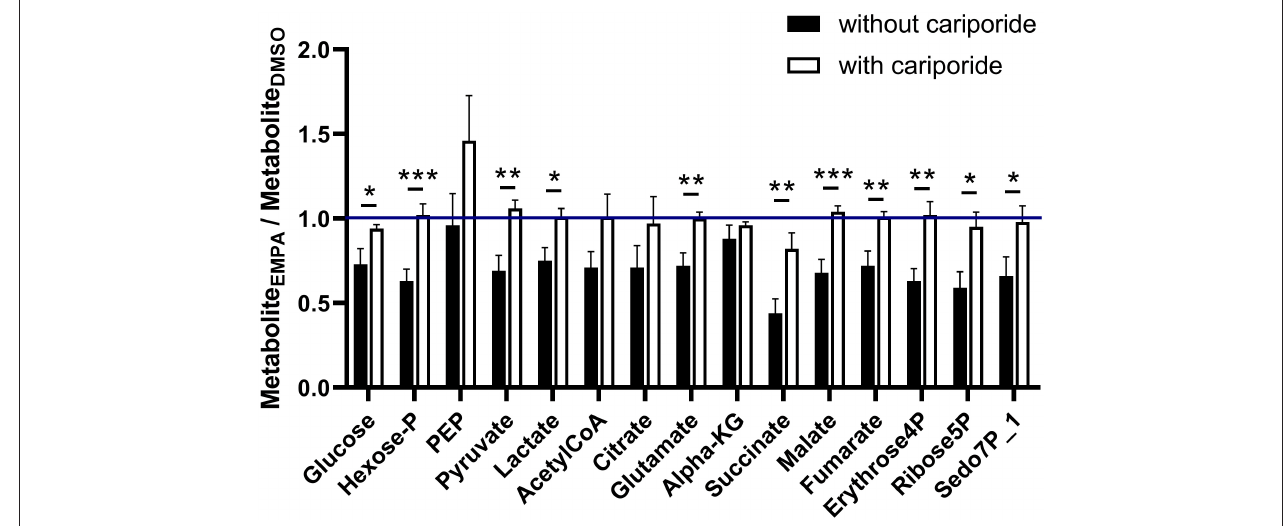
FIGURE 5 | NHE-1 inhibition (cariporide) attenuates Empa’s lowering effect on metabolic intermediate levels of glucose metabolism. Cariporide’s effects on EMPA-induced relative changes in total (unlabeled plus labeled) metabolite content (AU) in the 13 C glucose perfusions. DMSO ( n = 8), EMPA ( n = 8), DMSO + Cariporide ( n = 9), EMPA + Cariporide ( n = 8); * P < 0.05, ** P < 0.01, *** P <